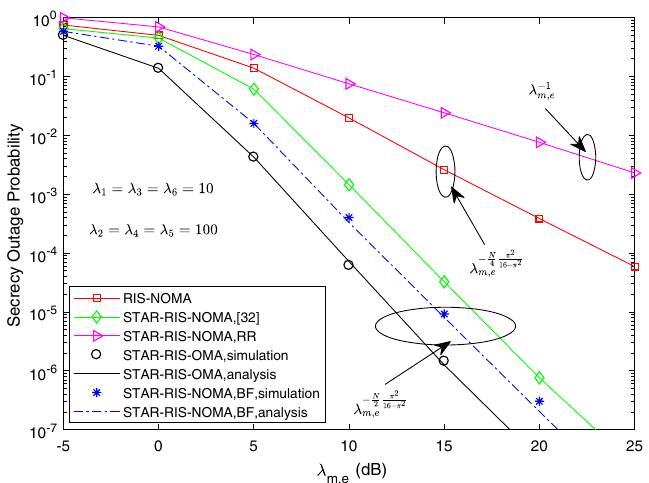
Fig. 9 The theoretical results and simulation results of SOP versus (cid:31) m , e . When the transmission power is constant, The impact of the (cid:31) m , e on the SOP